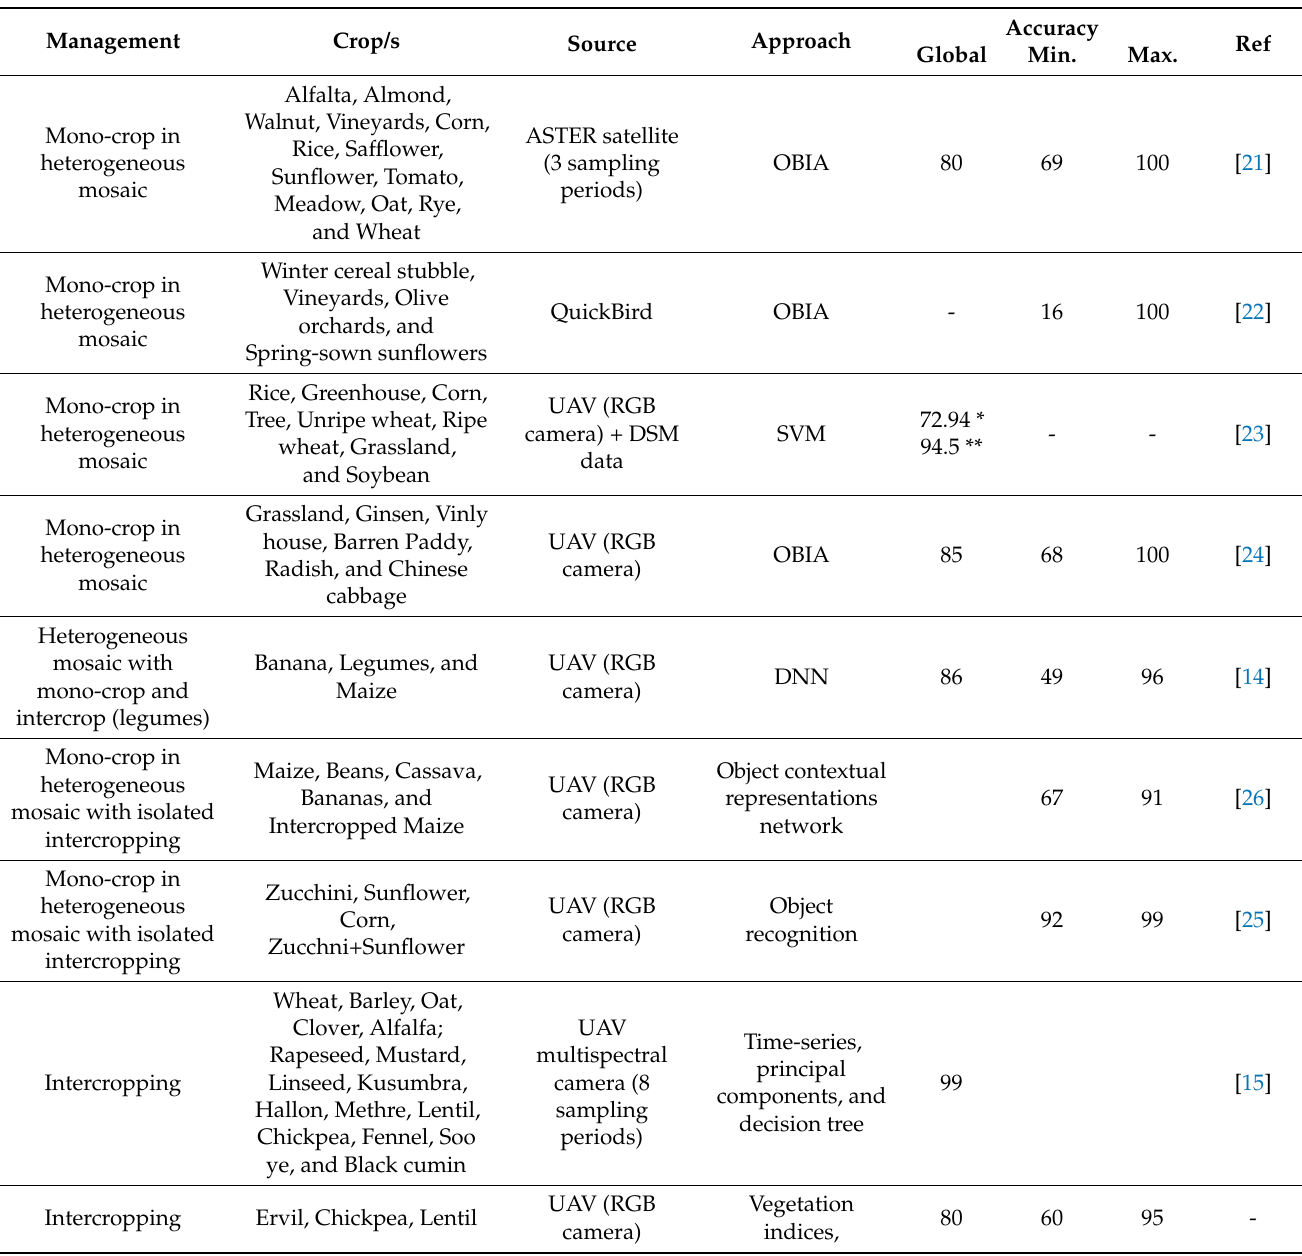
Table 8. Summary of accuracies attained by other methods and the proposed